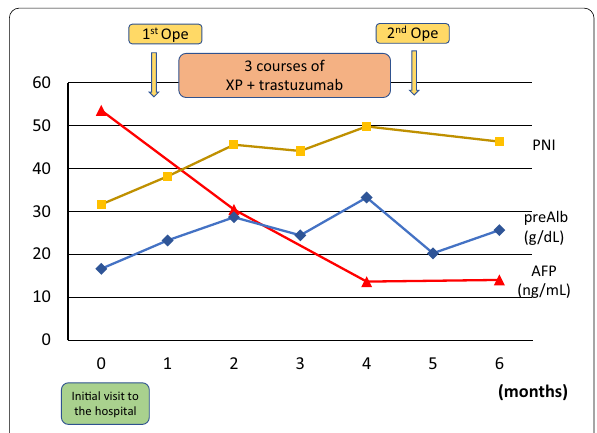
Fig. 6 Clinical course of the present case. The clinical course and date since “initial visit to the hospital”. “First Ope” is gastro-jejunal bypass and “Second Ope” is distal gastrectomy with D2 lymphadenectomy and partial hepatectomy. Normal range; AFP (alpha-fetoprotein;) 10.0 (ng/mL), PNI (prognostic Nutritional ≤ Index) 40, and Pre-ALB (pre-albumin) 21.0–41.0 ≥